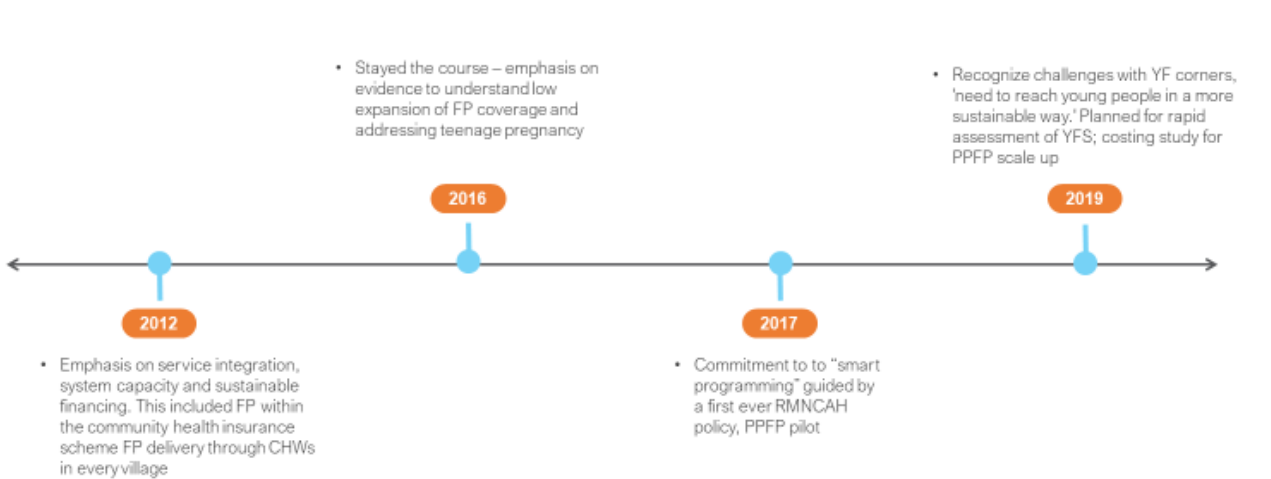
Figure 7. Rwanda FP2020 commitments and timeline. CHWs – community health workers; RMNCAH – reproductive, maternal, newborn, child and adolescent health; PPFP – post-partum FP; YF – youth friendly; YFS – youth friendly